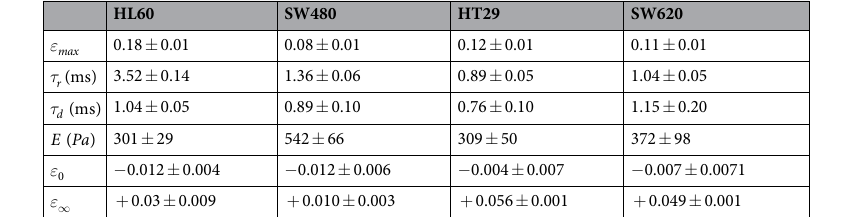
Table 1. Multiple characteristic parameters for HL60 (N = 50), SW480 (N = 56), HT29 (N = 49) and SW620 (N = 50) cell lines, extracted from the deformation traces of cells deforming at the stagnation point of an extensional flow at 5 µ l/min in the shear regime ( µ ≈ 33